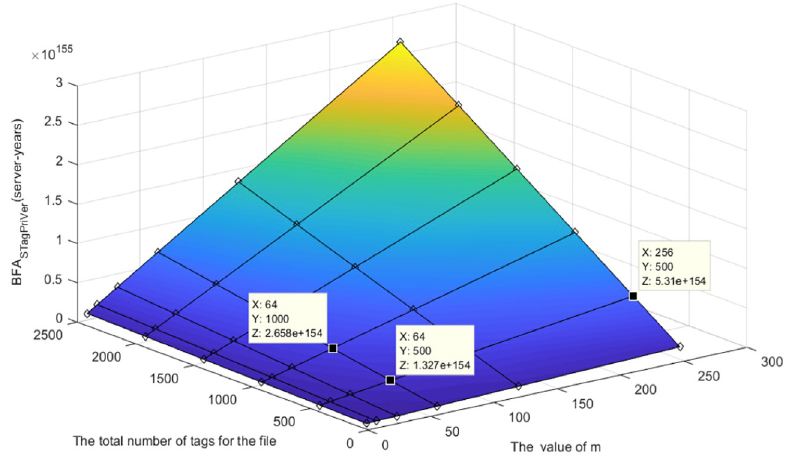
Fig 7. BFA STagPriVer vs the length of tag ( m ) and the total number of IDTags for a data file ( d ).